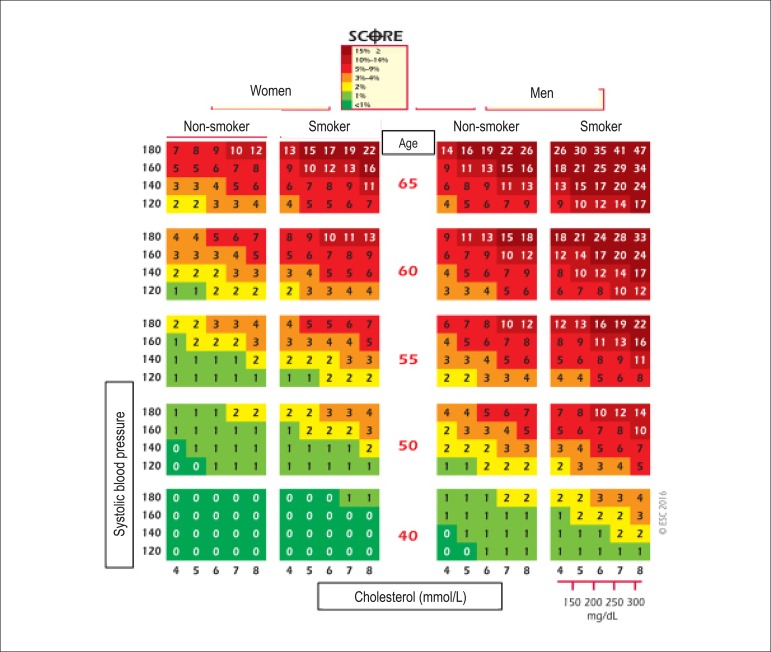
Calculation of 10-year risk of fatal cardiovascular event, in populations of countries with high cardiovascular risk, considering the risk factors of age, sex, smoking, total cholesterol, and systolic blood pressure. Cart from the SCORE (Systematic Coronary Risk Evaluation) Study. The color scale varying from red to green corresponds to percent risk over 10 years, described in the upper part of the Table. Adapted from Piepoli MF et al.120